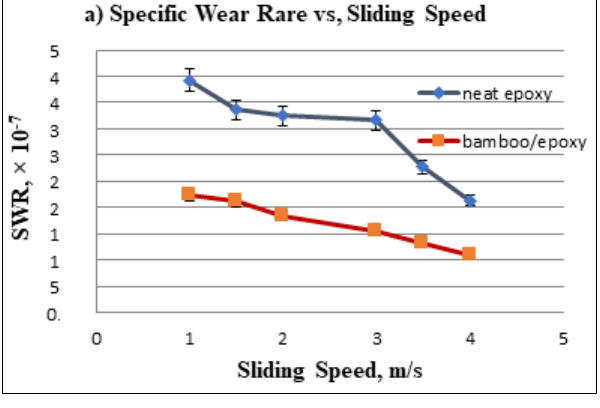
Figure 6. Relationship between weight lost and sliding distance, sliding speed and applied load.